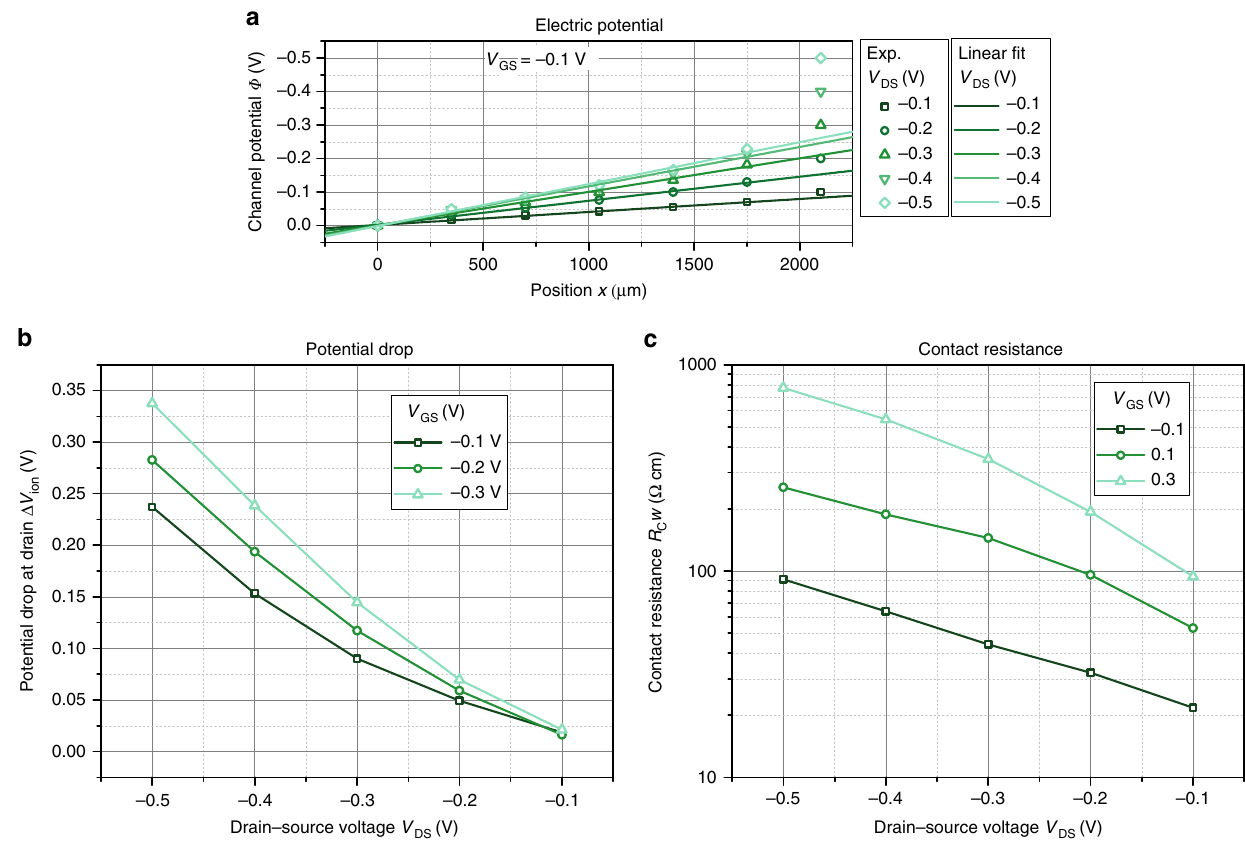
Fig. 10 Describing ion accumulation by contact resistances. a Channel potential pro fi le at the gate potential V GS = − 0.1 V. The lines are linear fi ts. b Potential drop at drain contact for different gate and drain voltages. c Contact resistance at varying gate and drain